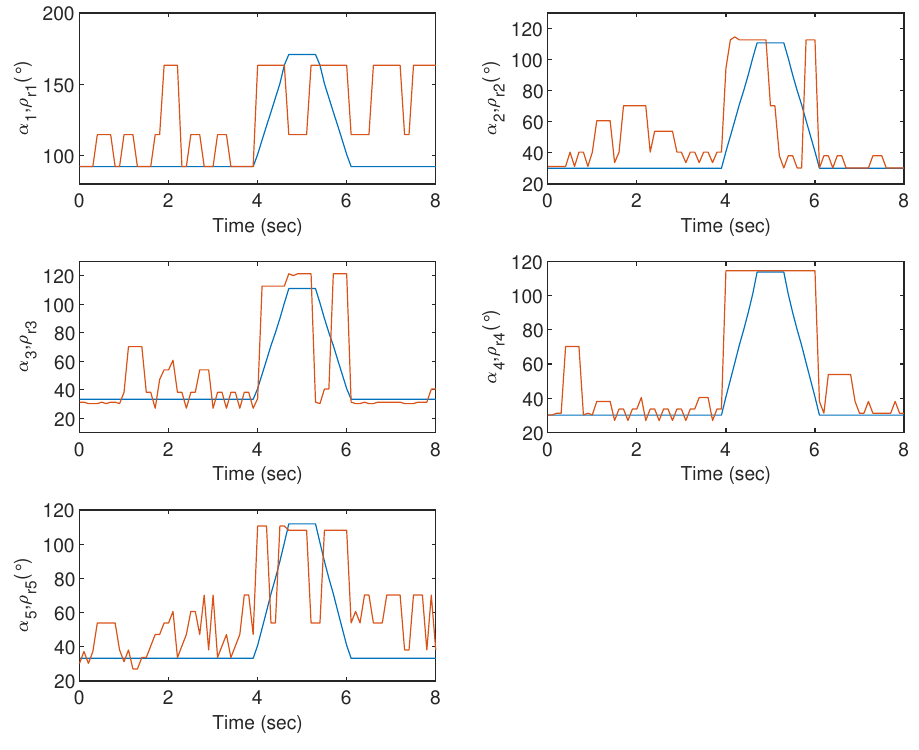
Figure 9. Goniometric glove response with respect to a grab-release-grab movement. The finger goniometry and the raw sensor outputs are represented by ρ ri (blue line) and α i (orange line)